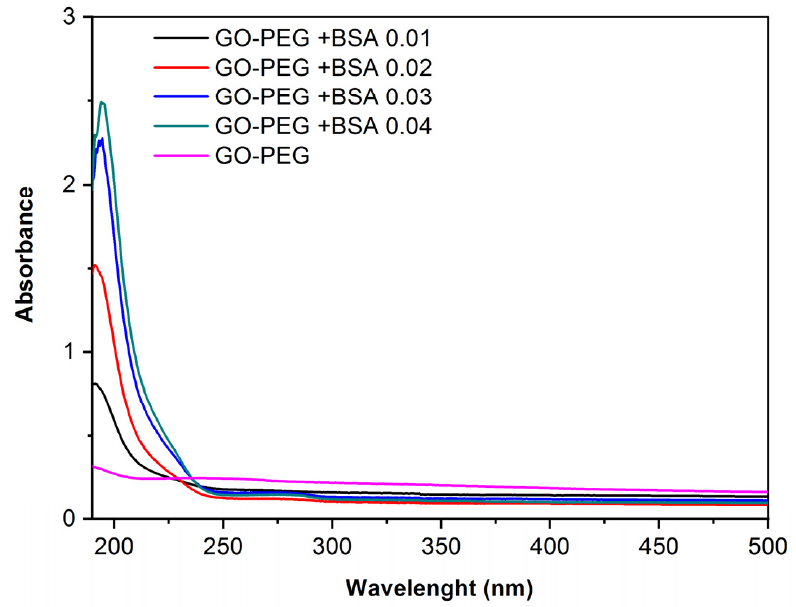
Figure 4. Absorbance vs. wavelength. Spectra of GO-PEG (0.125 mg/mL) and GO-PEG with differ- ent concentrations of BSA obtained by UV-Vis spectrophotometer.